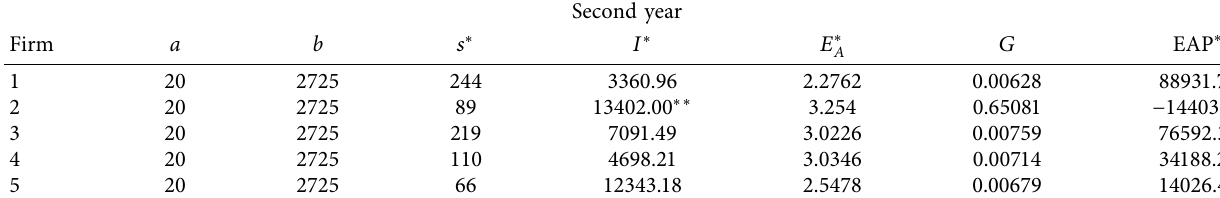
Table 5: Optimum solutions for the second